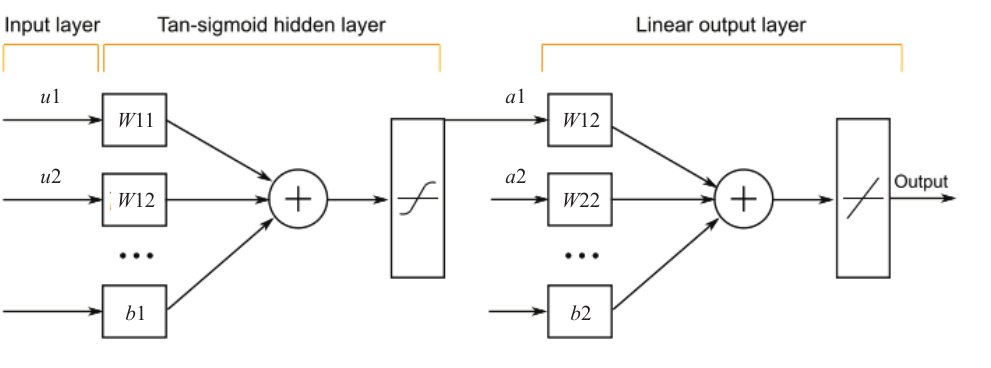
Fig. 2 – Schematic representation of the neural